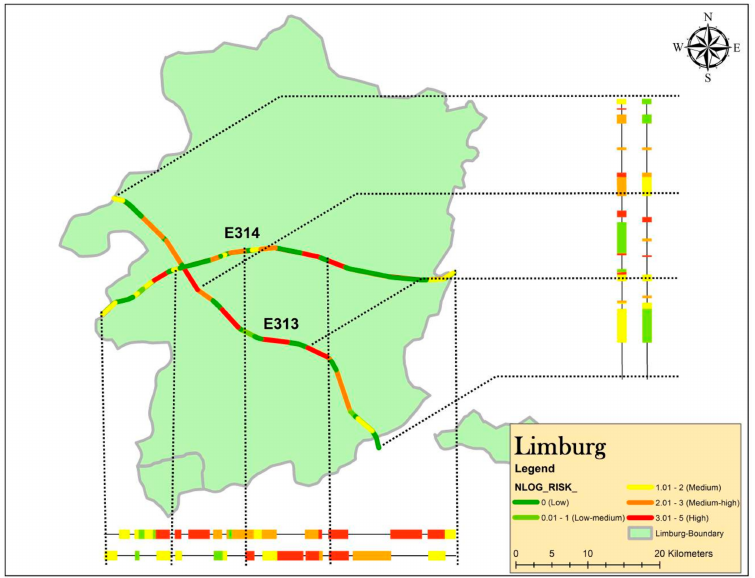
Figure 2. Risk based Straight Line Map for Motorways